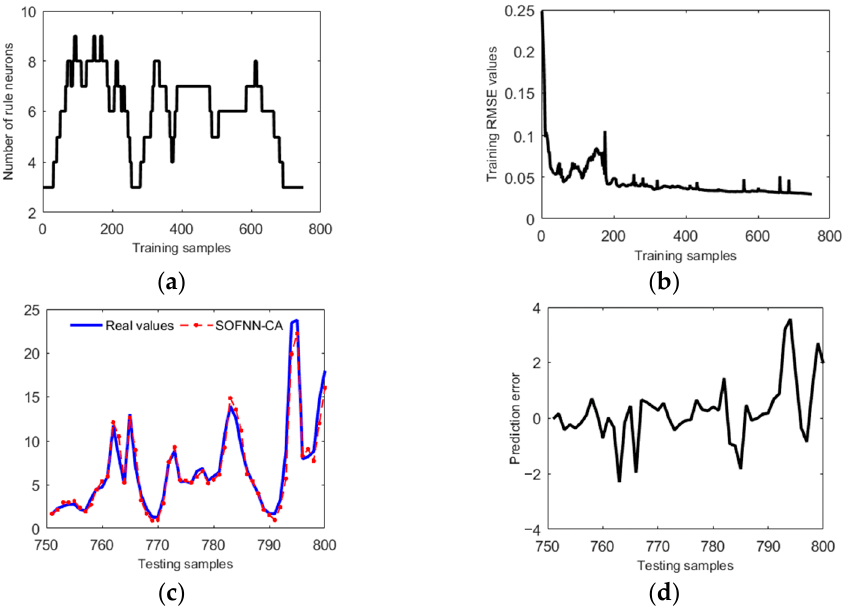
Figure 11. ( a ) Training neuron change plot; ( b ) training RMSE plot; ( c ) test result plot; ( d ) test error